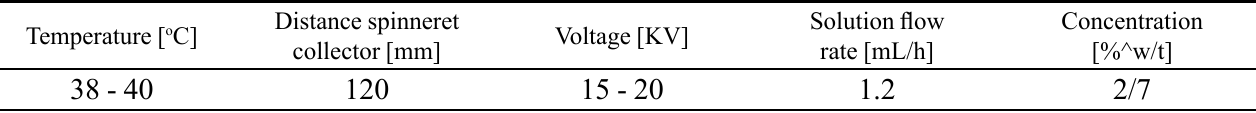
TABLE I - Optimum conditions for electrospinning Temperature [ o